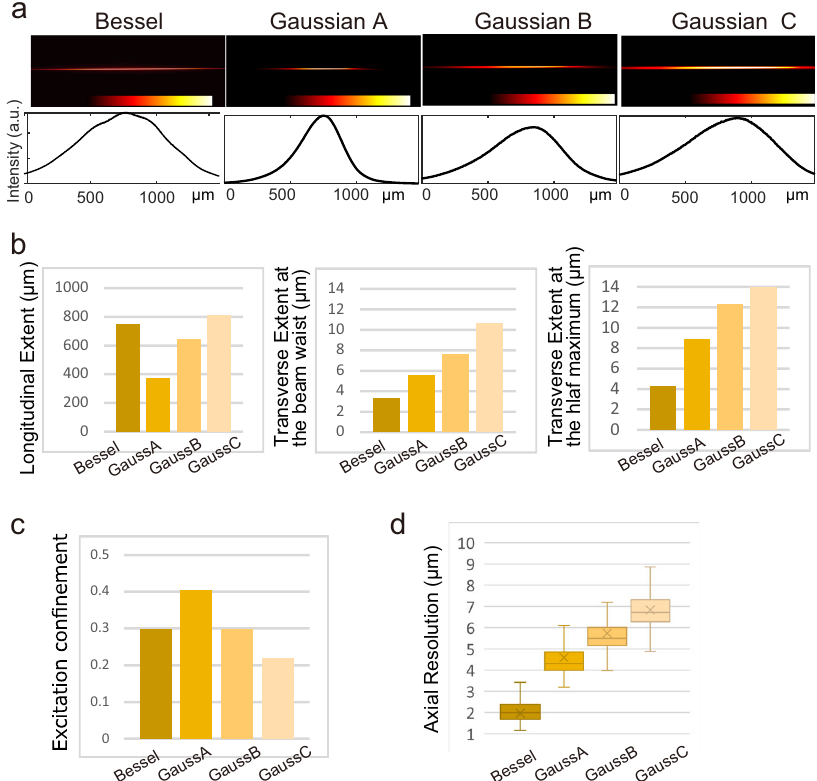
Fig. 3 Comparisons of the optical properties between the Gaussian and Bessel beams. a Laser line pro fi les after transmission of the IO lens for Bessel ( d 1 = 280 mm and d 2 ¼ 148 mm) and three Gaussian beams. Fluorescent signals emitted by the sulforhodamine B solution are imaged. a.u. arbitrary unit. b Quanti fi ed line pro fi les. FWHMs along the longitudinal direction (left), transverse direction at the beam waist (middle), and the half-maximum intensity point (right). c Excitation con fi nements. b , c For each line pro fi le quanti fi cation, a snapshot is analyzed. d PSF values based on the fl uorescent bead measurements. The PSF calculation employed over 90 beads as data points. In the box plots, the box lines indicate the fi rst quantile, median, and third quantile. Lower and upper whiskers indicate the minimum and maximum, respectively. The Cross mark represents the